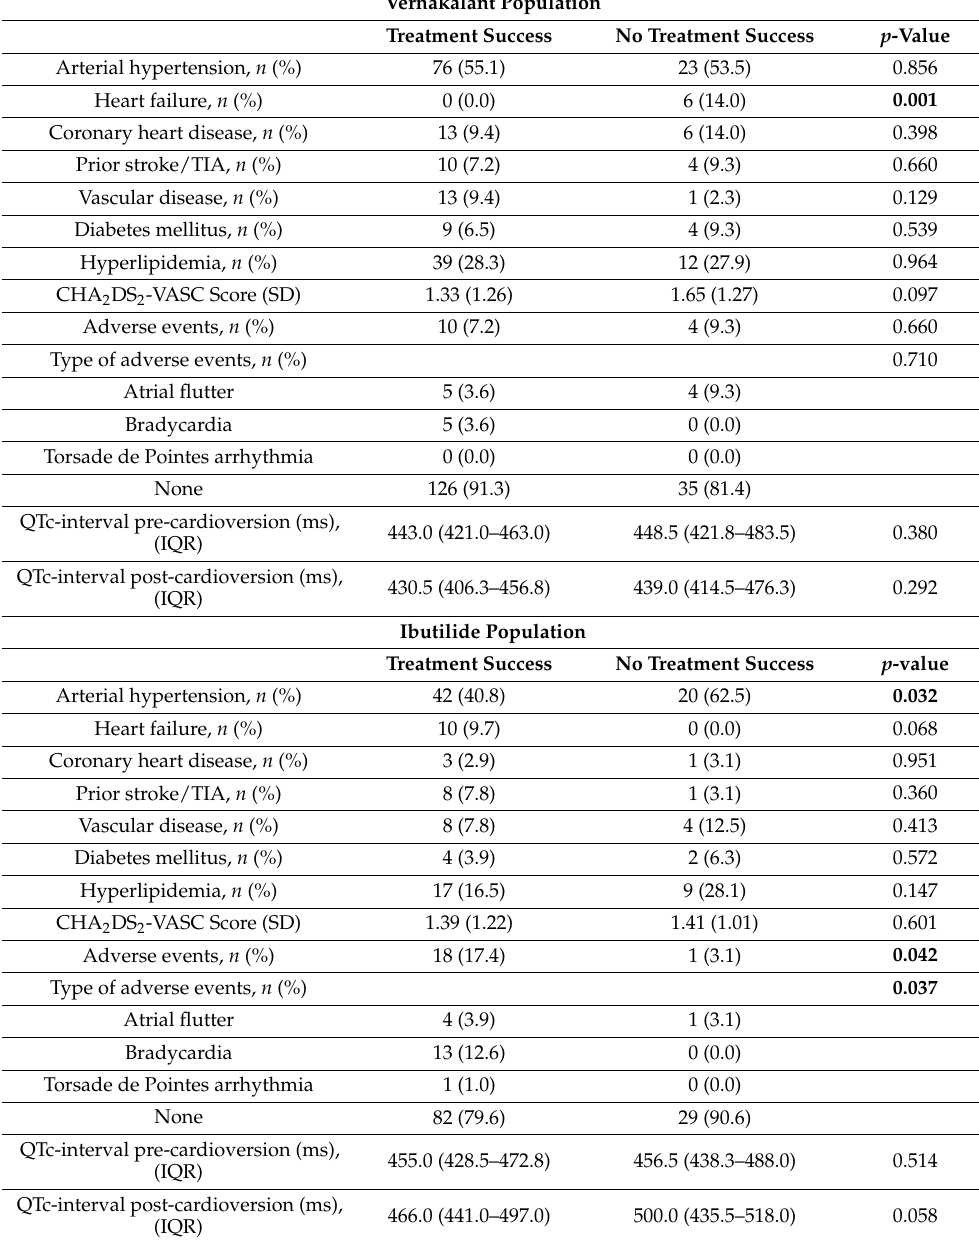
Table 3. Comorbidities and conversion